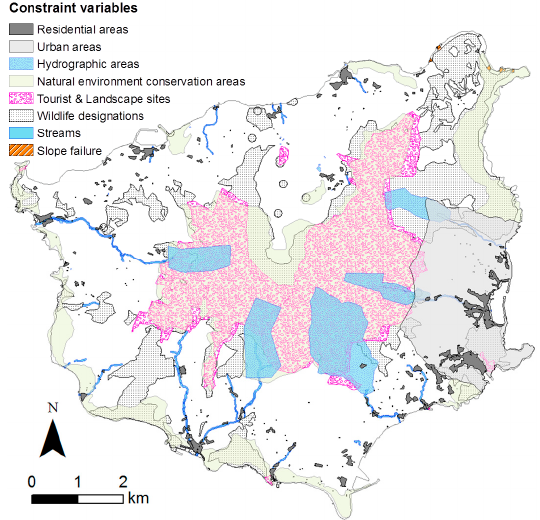
Figure A1. Distributions of constraint areas used in this study.